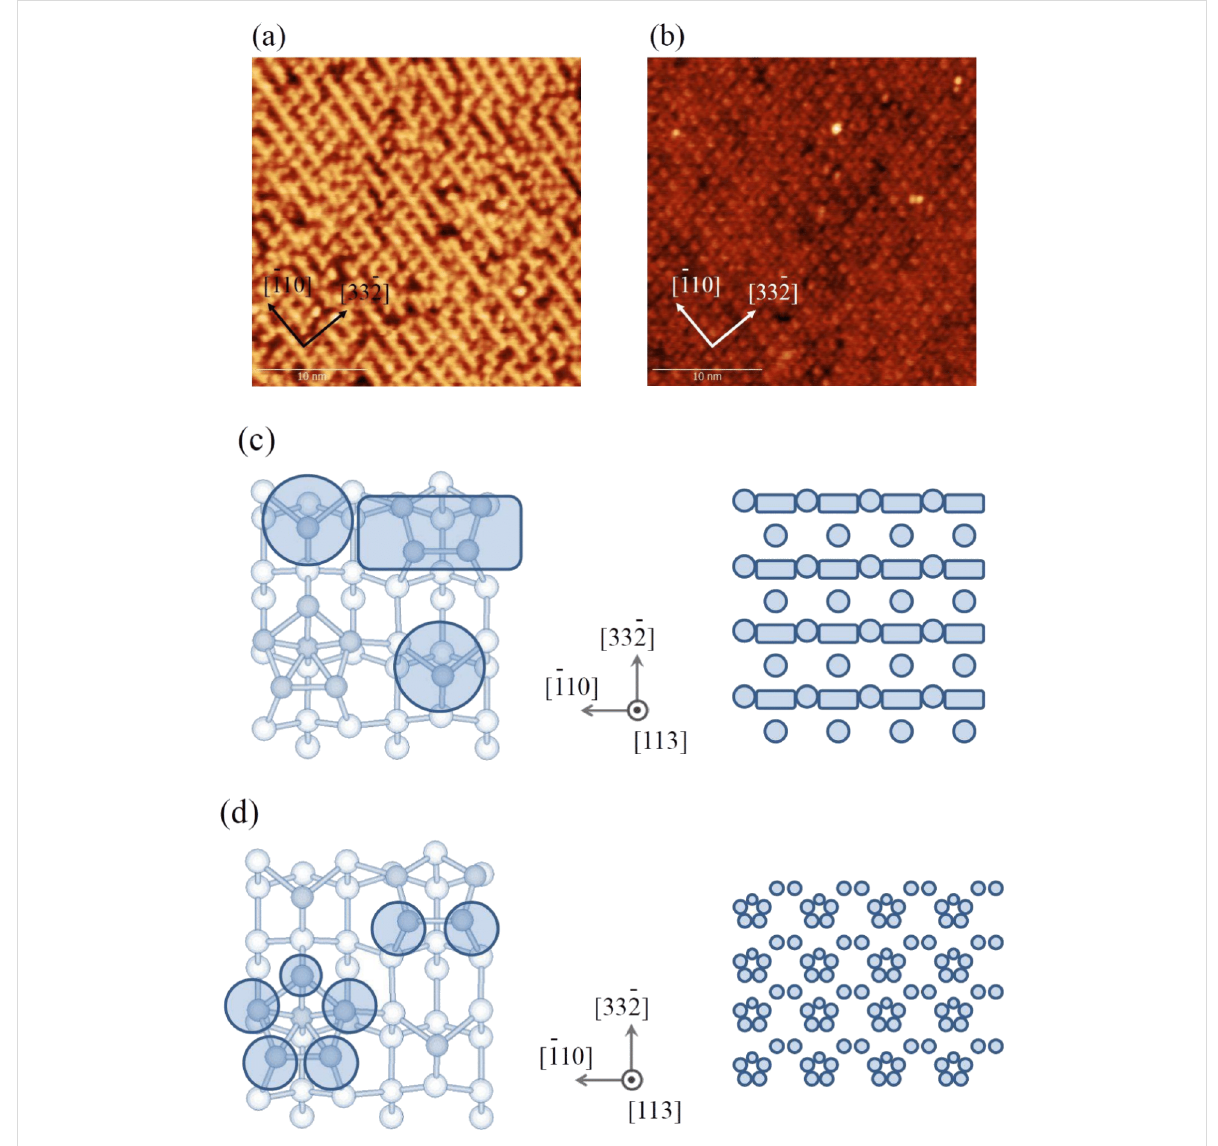
Figure 1: (a) Filled-state STM image of Si(113)-(3 × 2). Image size: 30 × 30 nm 2 , V s = − 2.0 V, I t = 0.05 nA. (b) Empty-state STM image of Si(113)-(3 × 2). Image size: 30 × 30 nm 2 , V s = +1.5 V, I t = 0.05 nA. (c) Shaded area superimposed on the schematic of Si(113)-(3 × 2) represents the bright area observed in the filled-state STM image. The periodic structure formed by these bright areas is shown in the right panel. (d) Shaded area superimposed on the schematic of Si(113)-(3 × 2) represents the bright area observed in the empty-state STM image. The periodic structure formed by these bright areas is shown in the right